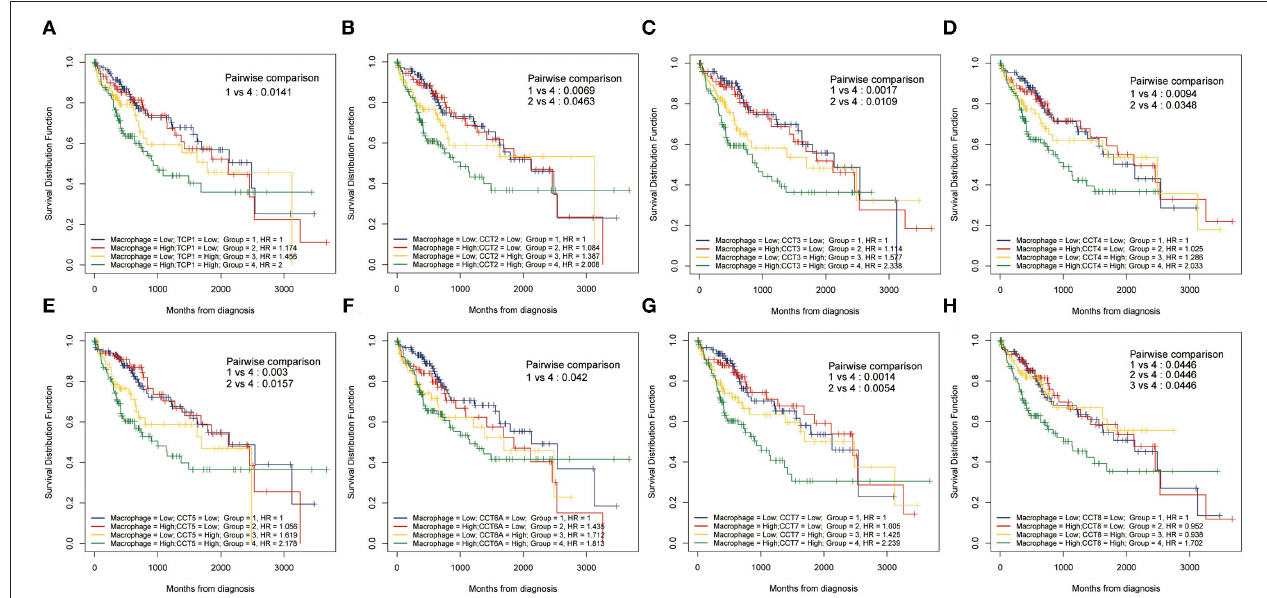
FIGURE 7 | Kaplan-Meier analysis using combinations CCT subunit genes and Macrophage score. Overall survival analysis of combinations Macrophage score and TCP1 (A) , CCT2 (B) , CCT3 (C) , CCT4 (D) , CCT5 (E) , CCT6A (F) , CCT7 (G) , and CCT8 (H)